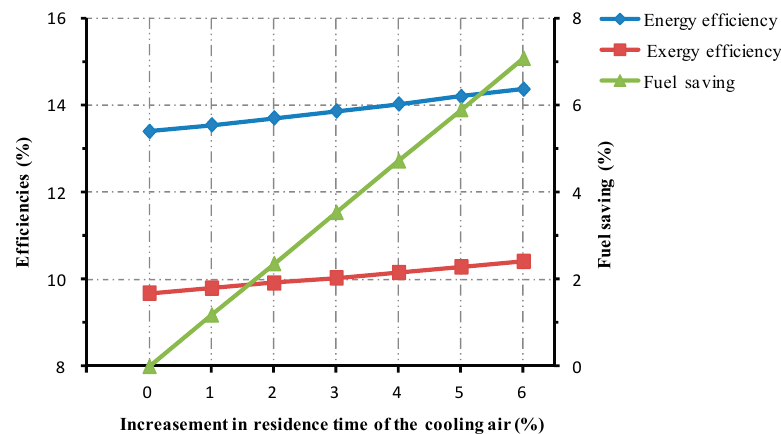
Figure 10. Impacts on energy and exergy efficiencies and fuel-saving of the roller kiln with changes in the residence time of the cooling air.